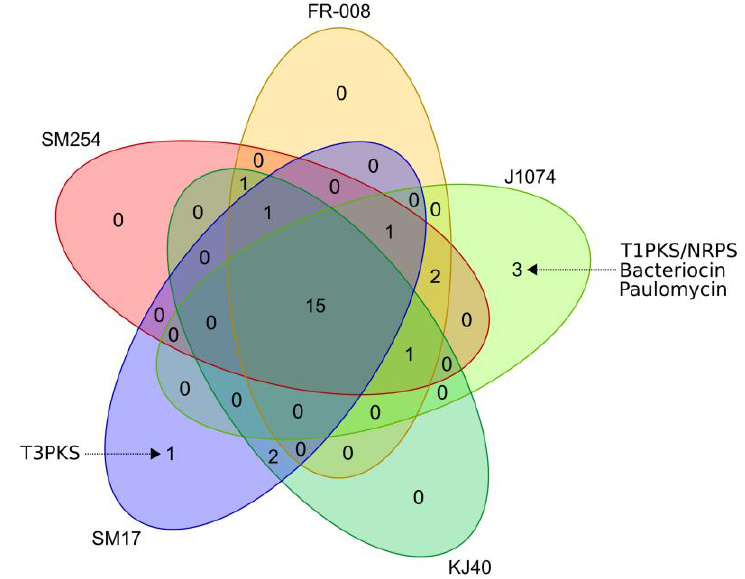
Figure 4. Venn diagram representing BGCs presence / absence in the genomes of the members of the albidoflavus phylogroup, determined using antiSMASH and BiG-SCAPE.